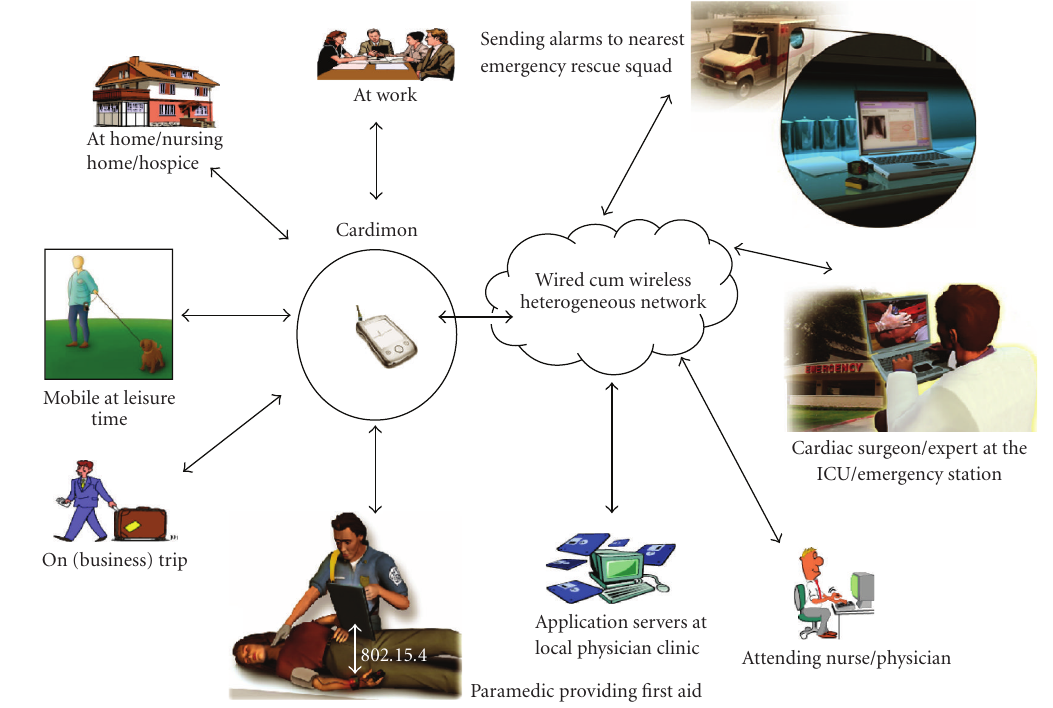
Figure 1: Ubiquitous monitoring of patients using xG